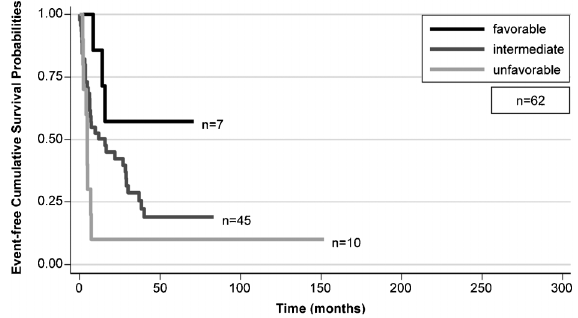
Figure 6. Event-free survival of patients who reached CR, by karyotype. P=0.009, comparing cytogenetic prognosis (log-rank